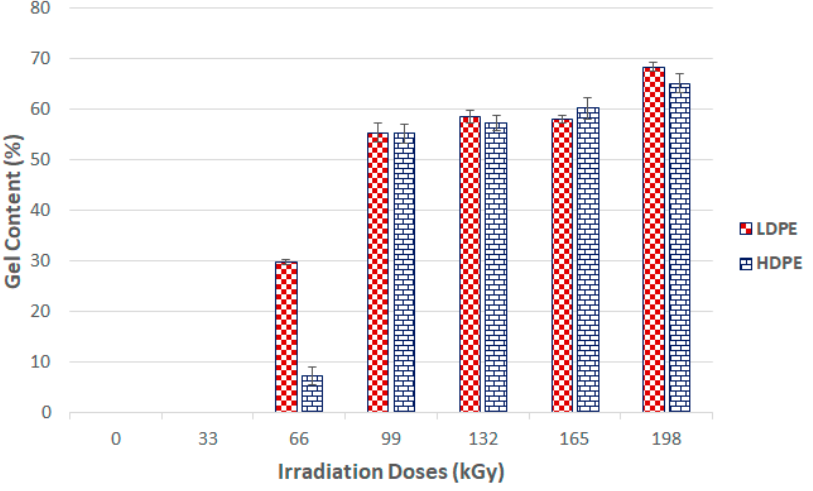
Figure 11. Gel content of irradiated LDPE and HDPE; the vertical line drawn at the top of the column represents the standard deviation.